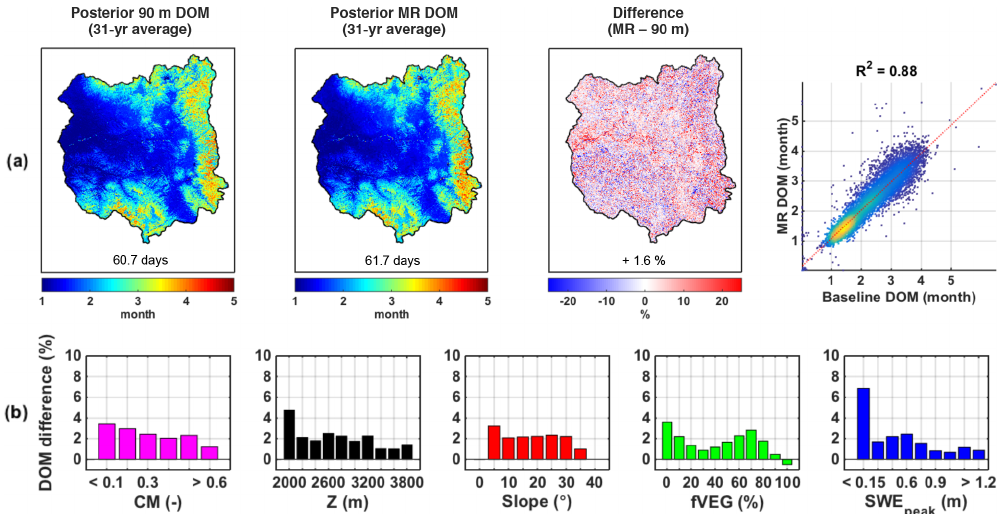
Figure 8. (a) Maps of pixel-wise 31-year-average duration of melt (DOM) over the upper Yampa River basin for the 90m baseline, the MR case, the percentage difference between the two approaches (MR − baseline), and the corresponding scatter plot. Basin averages are displayed at the bottom of each map. (b) Distribution of DOM relative difference with complexity metric (CM), elevation ( Z ), slope, forested fraction (fVEG), and SWE peak . Pixels with a 31-year-average SWE peak lower than 5cm were discarded from the analysis.